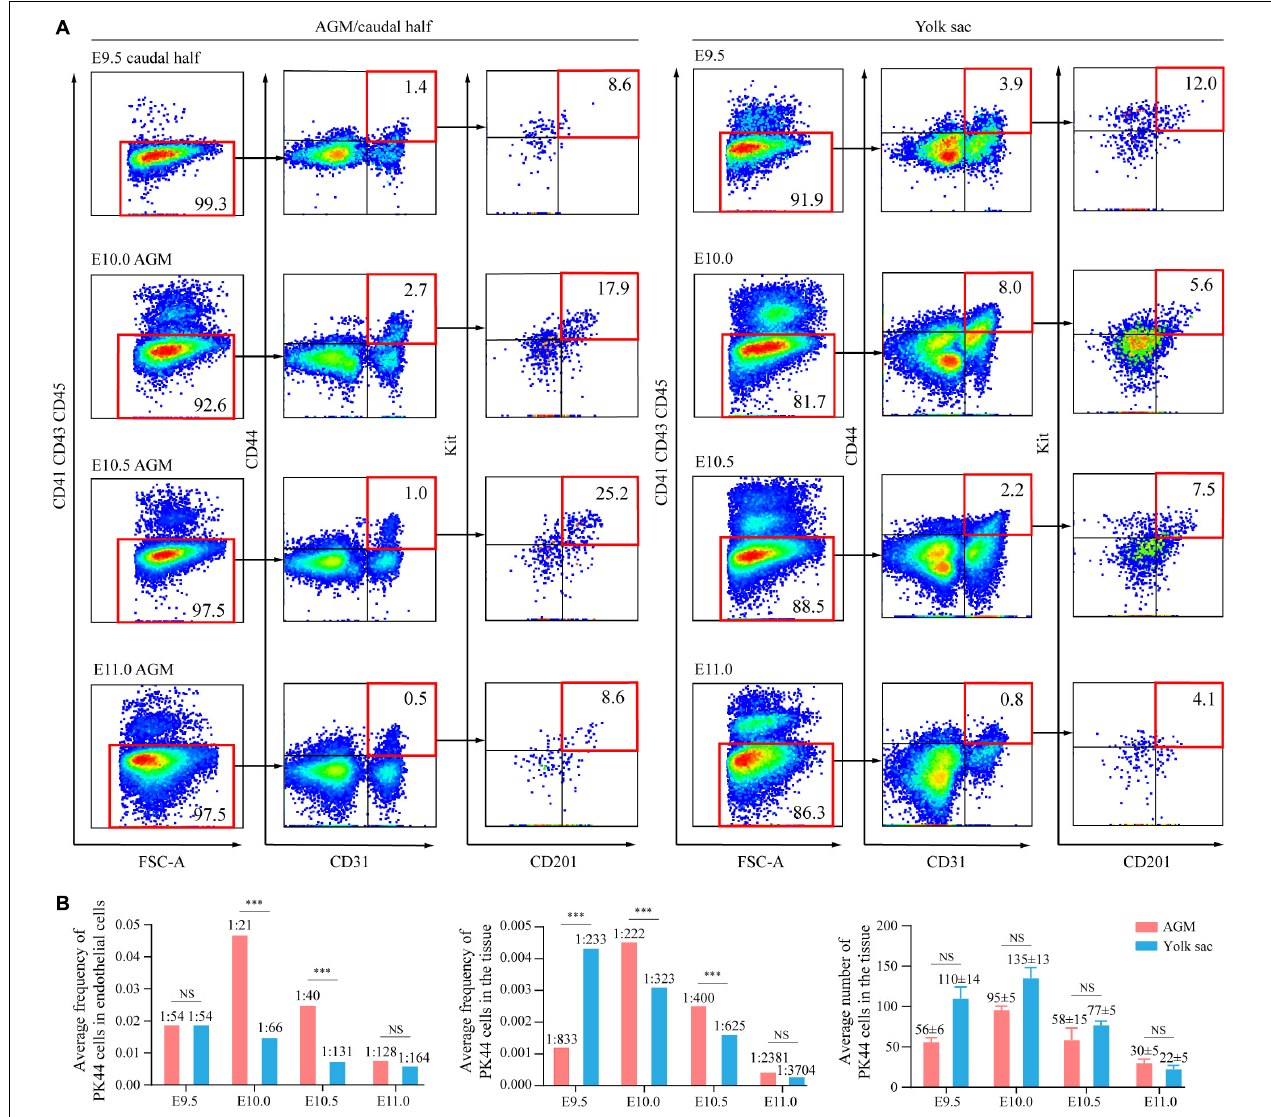
FIGURE 3 | Developmental dynamics of the immunophenotypic PK44 cells in AGM and yolk sac. (A) Representative FACS plots for AGM/caudal half and yolk sac PK44 cells from E9.5 to E11.0. (B) Graphs showing the proportions of PK44 cells in endothelial cells (CD41 - CD43 - CD45 - CD31 + ) (left) and in total cells of the corresponding tissues (middle). The statistical significance of differences was determined using Fisher’s exact test. ∗∗∗ P < 0.001. NS, not significant. The average numbers of PK44 cells in corresponding tissues are shown to the right. Data are means ± SD. Data are from three independent experiments. The statistical significance of differences was determined using Mann–Whitney test. NS, not